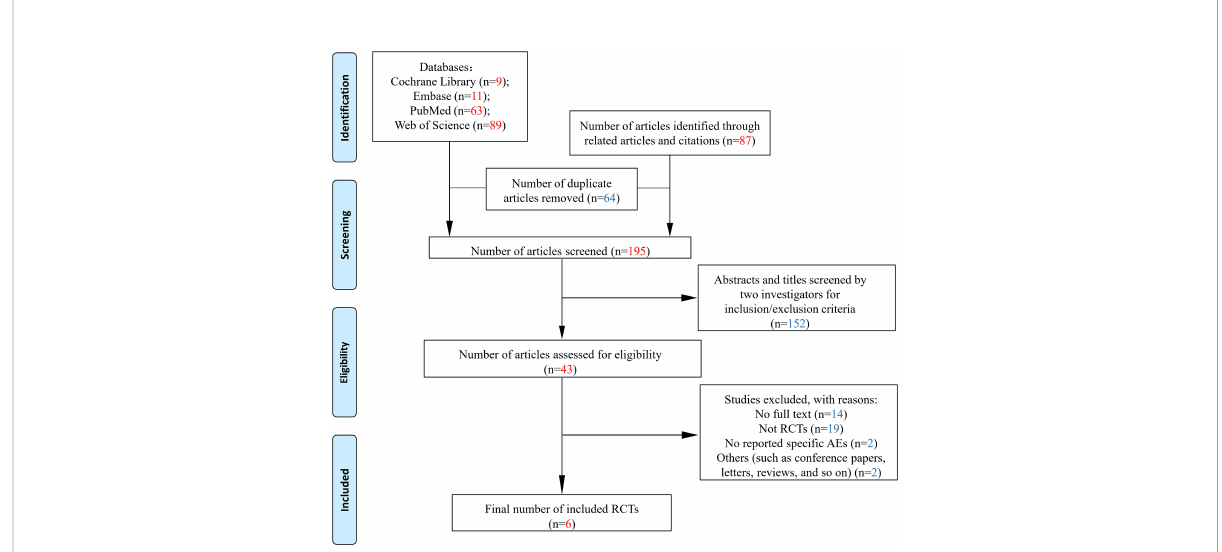
FIGURE 1 Flowchart of study inclusion according to the PRISMA 2009 guidelines. RCTs: randomized control trials; AEs, adverse